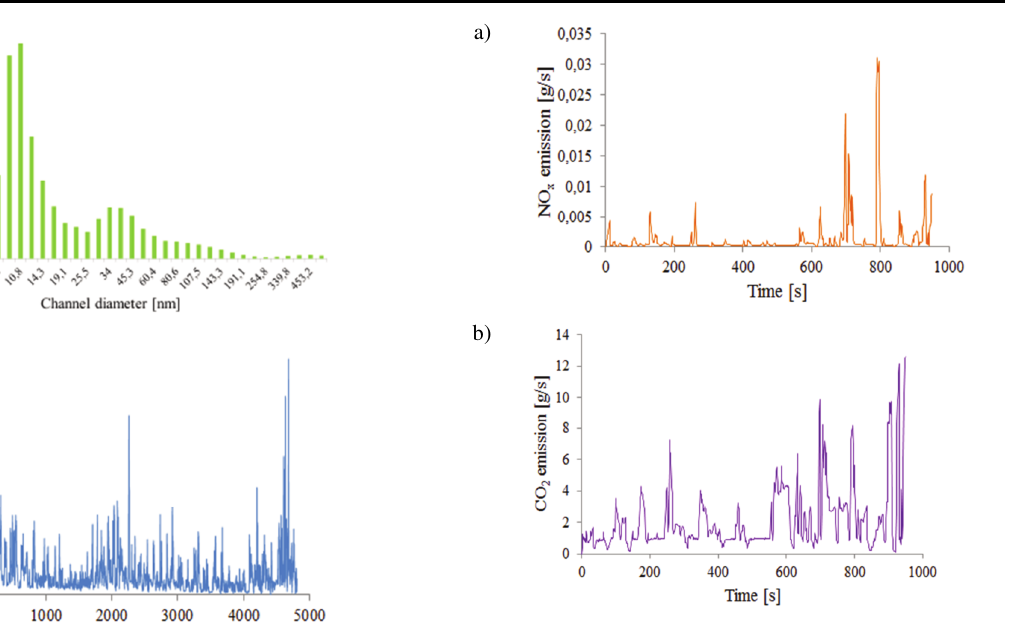
Fig. 7. Measured compounds emission per second: a) NO x , b) CO 2